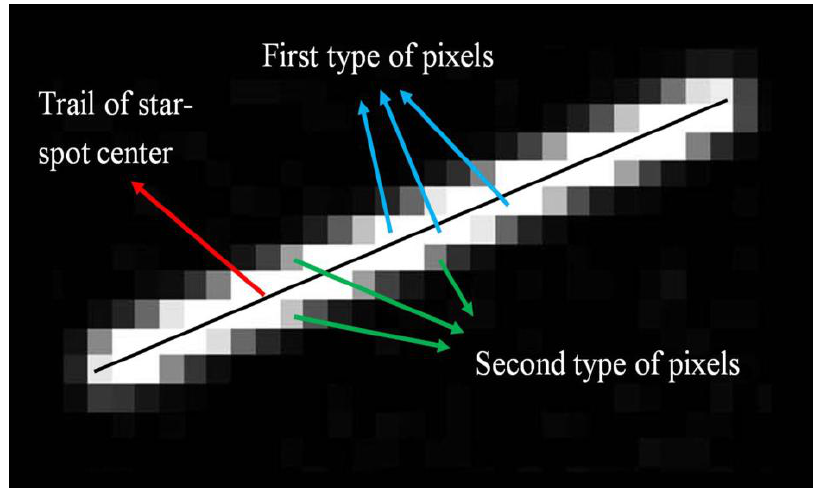
Figure 3. The first and second type of pixels in the star-spot